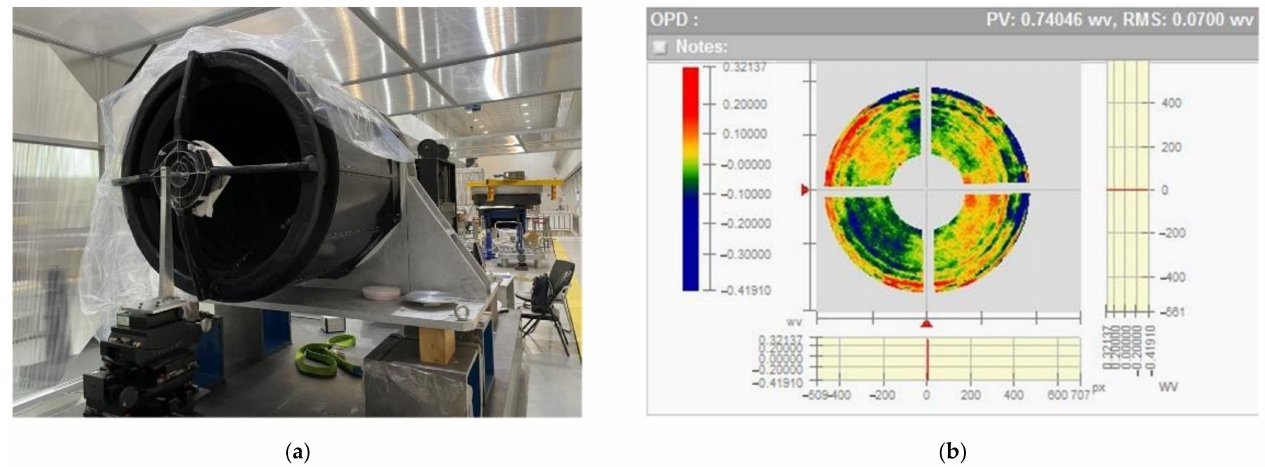
Figure 15. The test of wave aberration: ( a ) telescope assembly ( b ) wave